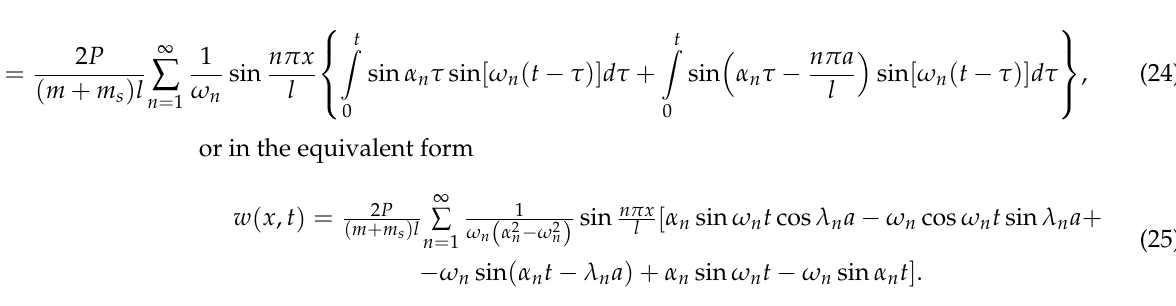
or in the equivalent form